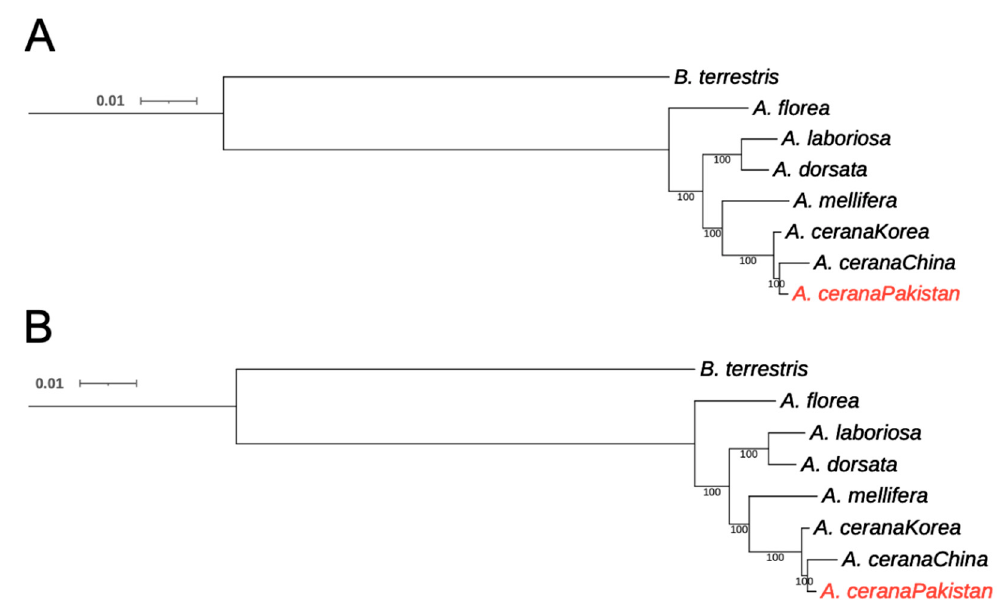
Figure 1. Maximum likelihood trees constructed by IQ-TREE ( A ) and RAxML-NG ( B ). Numbers on the nodes indicate bootstrap values.